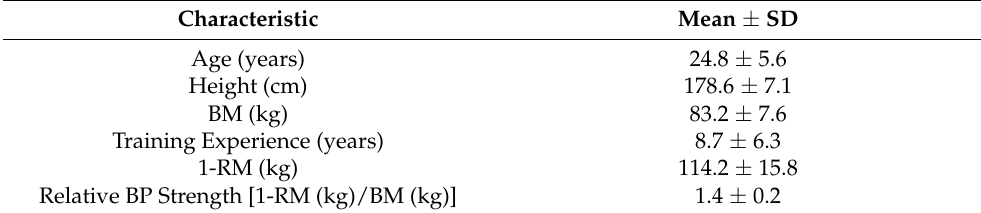
Table 1. Descriptive characteristics of participants ( n = 10).